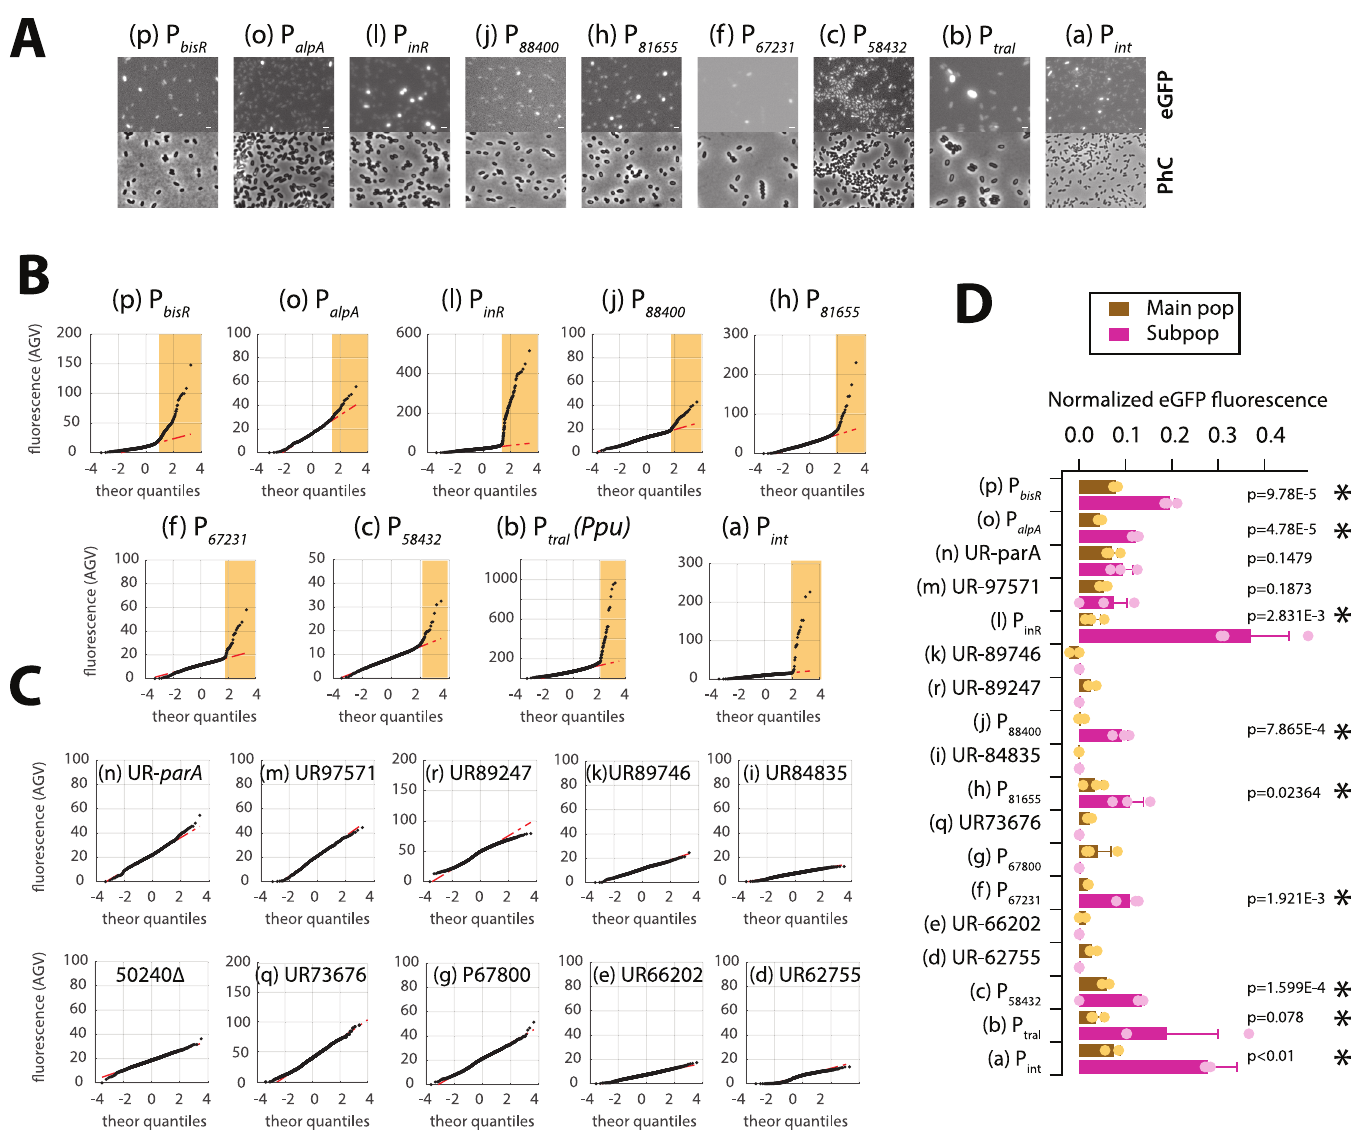
Fig 3. Identification of tc cell subpopulation-specific ICE clc promoters. A Auto-contrasted and cropped micrographs of P . knackmussii B13 strains (exception construct b in P . putida ICE clc , Ppu) grown on 3CBA imaged in stationary phase for eGFP fluorescence of the indicated construct or in phase-contrast (PhC). White bars indicate 1 μ m length. Letters and fragments corresponding to Fig 1 locations. P, putative promoter; UR, upstream region. B Quantile-quantile plot representations of stationary phase reporter fluorescence (each dot is value from a single cell; red line is linear regression on the fluorescence distribution of the main population). Yellow zones point to tc cell subpopulations. Fluorescence values scaled to zero by subtracting image background. C As ( B ) but for the tested constructs without detectable subpopulation expression. D Mean normalized fluorescence values (bars) ± one SD (whiskers) from 3 replicate strains of P . knackmussii B13 or P . putida ICE clc (construct b) in stationary phase on 3CBA with independent mini-transposon-inserted reporter constructs. Brown bars, value of the main population; magenta bars, values of the identified tc cell subpopulation (if any). Colored dots, individual replicate values. Asterisks point to those constructs showing significantly higher promoter expression in the subpopulation than in the main population ( n = 3 or 4, p-values from paired one-sided t-test). region upstream of ORF58432 did not show any depletion of mapped reads (S2 Fig), and, thus, does not confirm the weak observed promoter activity in isolation (Fig 3B). On the other hand, upstream regions of the ORFs 73676, 84835 and 89247 showed clear increase in mapped read coverage in 3CBA-grown stationary phase compared to exponential phase or succinate- stationary phase cultures (S2 Fig), but this was not associated with stationary phase expression